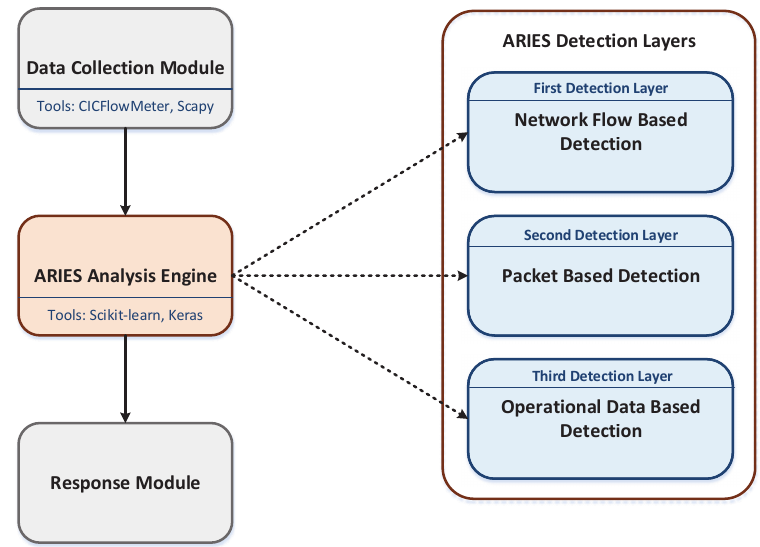
Figure 2. ARIES Architecture.